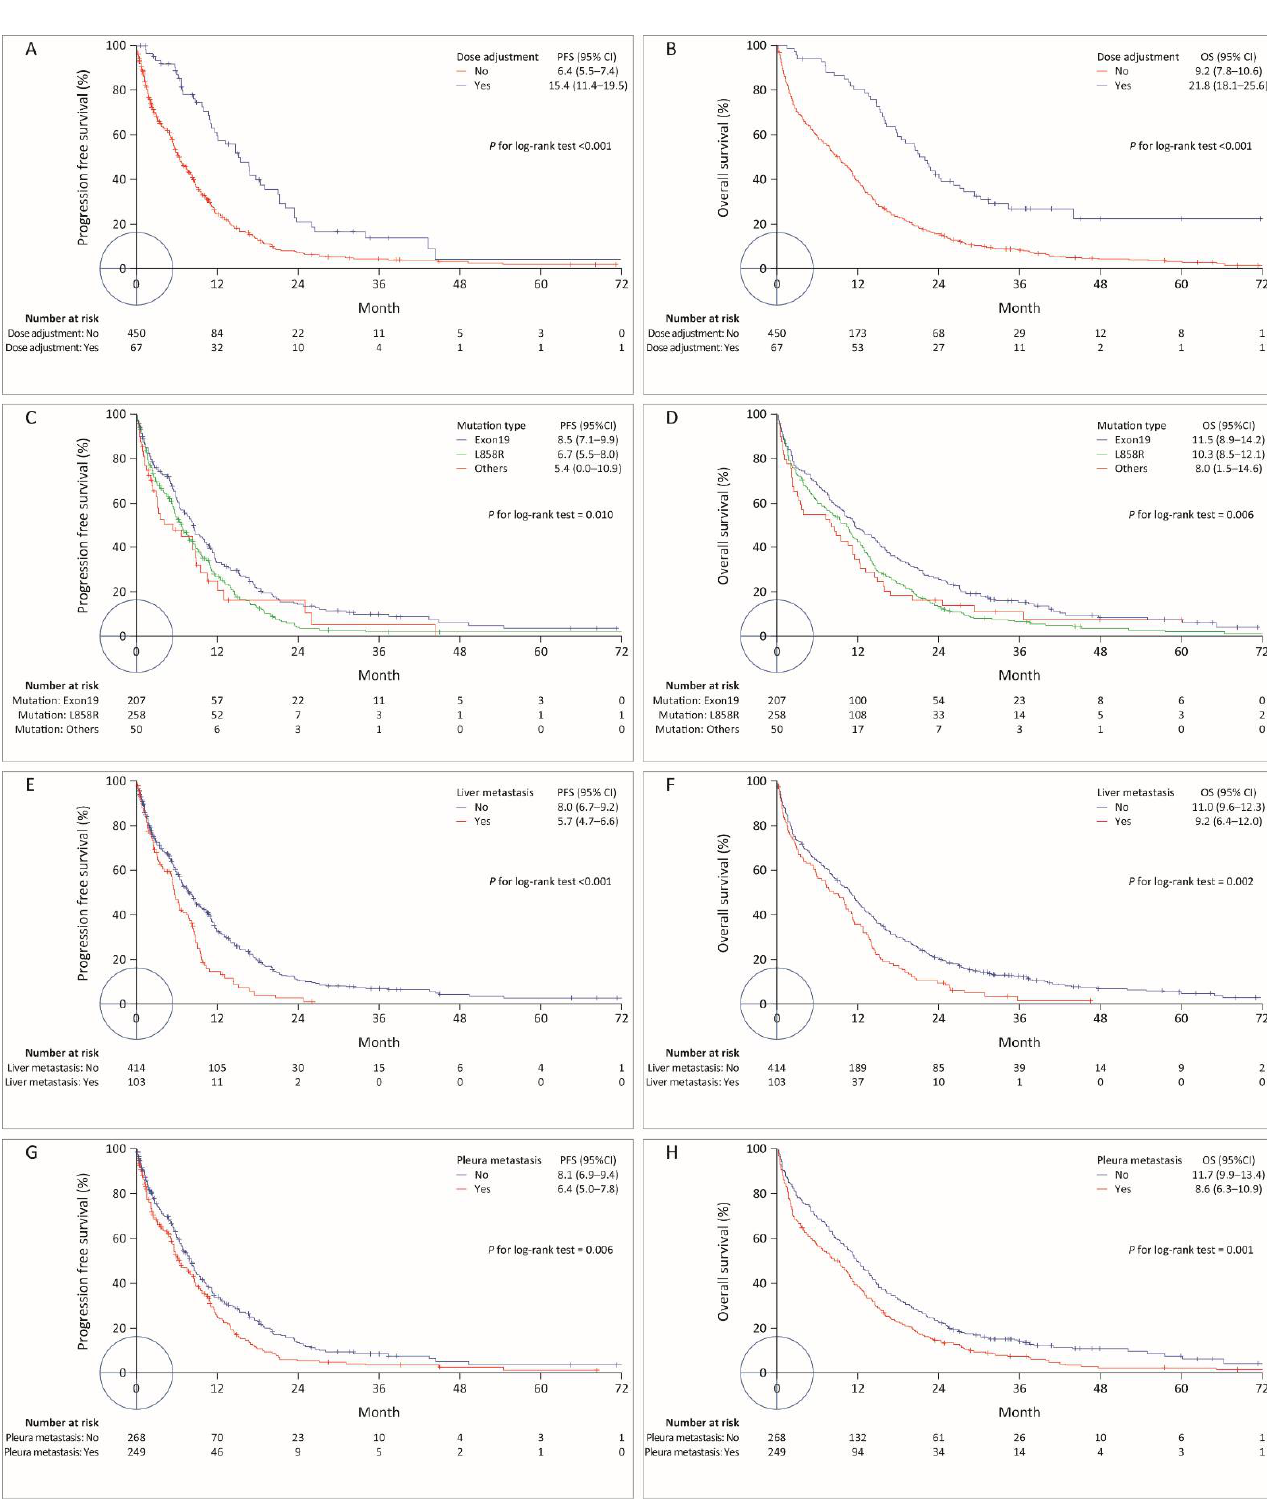
Figure 3. Kaplan–Meier survival curves indicating PFS ( A , C , E , G ) and OS ( B , D , F , H ) among patients stratified according to dose adjustment ( A , B ), mutation status ( C , D ), liver metastasis ( E , F ), and pleural metastasis ( G , H ). PFS, progression-free survival; OS, overall survival.